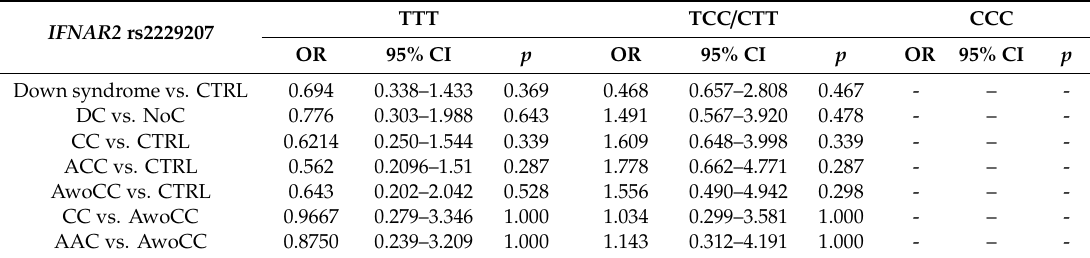
Table 4. Statistical analyses of di ff erences in genotype frequencies between patients with DS and control